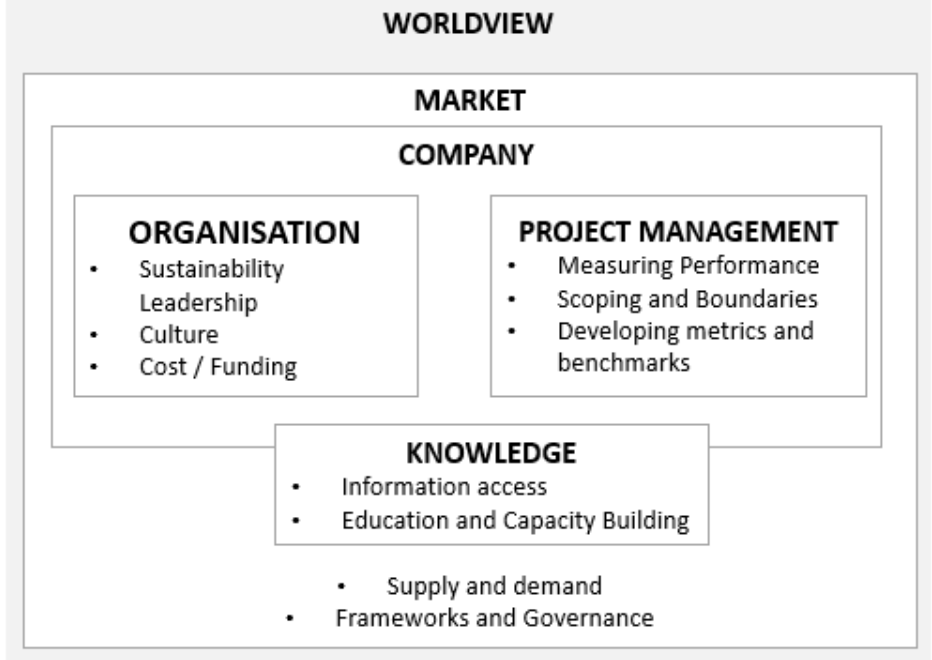
Figure 1. Context and relationships towards mainstreaming.